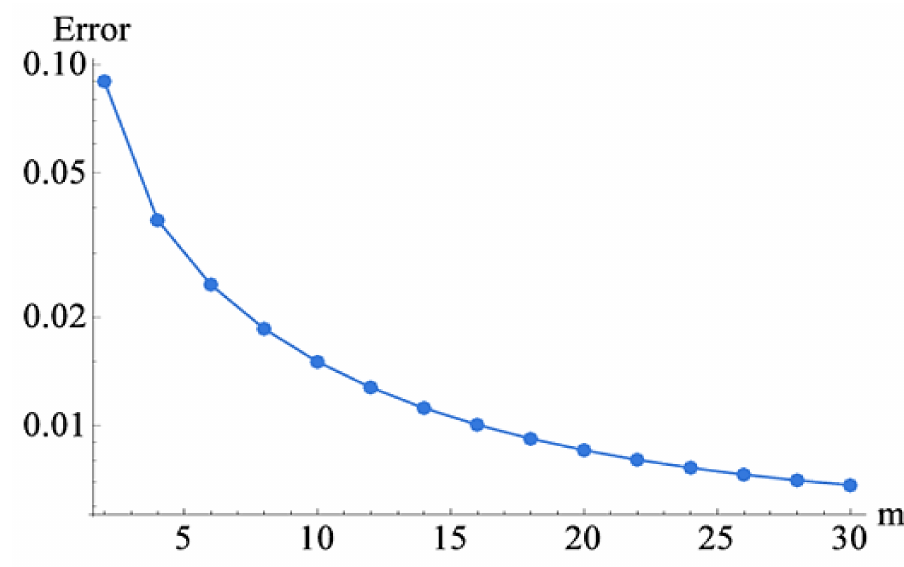
Figure 2. The convergence approach up to 30th order iterations.